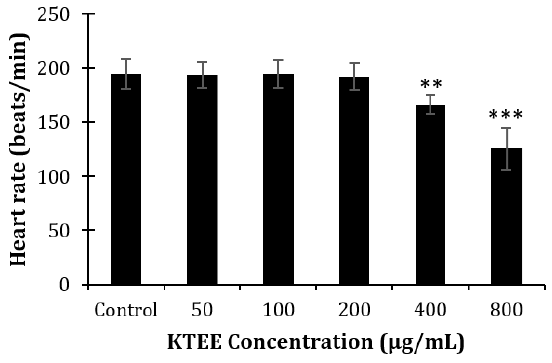
Figure 3. The heart rate of the larvae zebrafish at 96 hpf. Different means with normal groups *** P<0.001; ** P<0.01